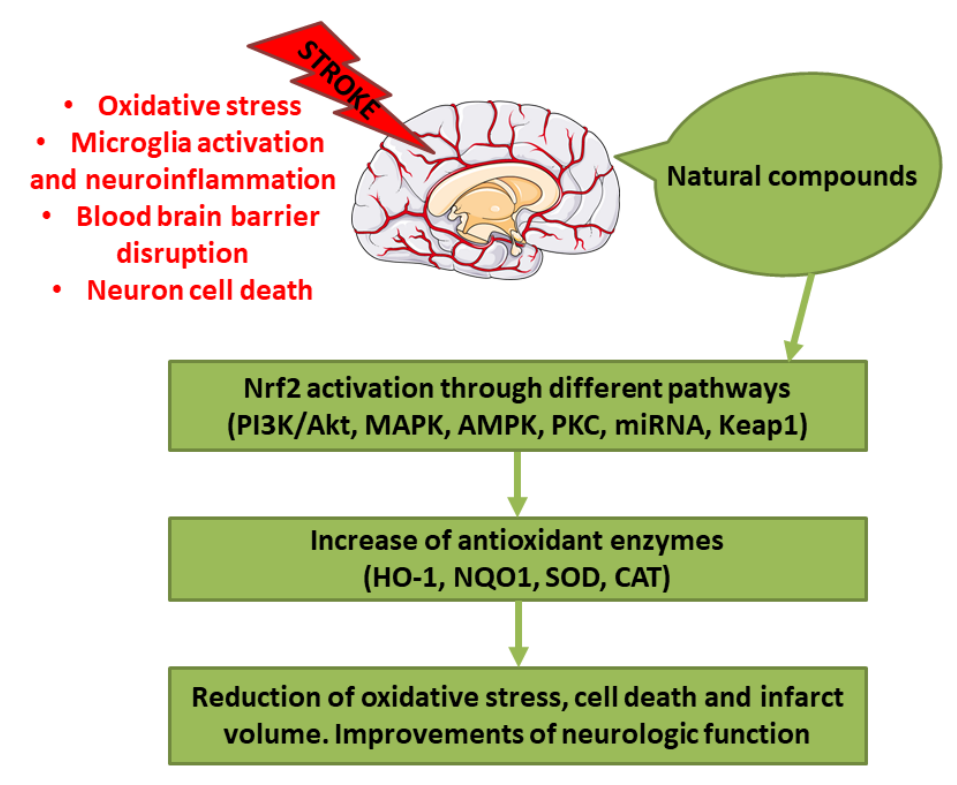
Figure 15. Schematic representation of stroke neurotoxic insults and of the actions exerted by the bioactive compounds. The figure was made taking the images from Servier Medical Art (available at http: // smart.servier.com / ), licensed under a Creative Commons Attribution 3.0 Unported License (https: // creativecommons.org / licenses / by / 3.0 / ). AMPK, monophosphate-activated protein kinase; CAT, catalase; HO-1, Heme oxygenase 1; Keap1, Kelch- like ECH- associated protein 1; MAPK, Mitogen-Activated Protein Kinas; miRNA, microRNA; NQO1, NAD(P)H quinone oxidoreductase 1; PI3K, phosphoinositide 3-kinases; PKC, protein kinase C; SOD, Superoxide dismutase.